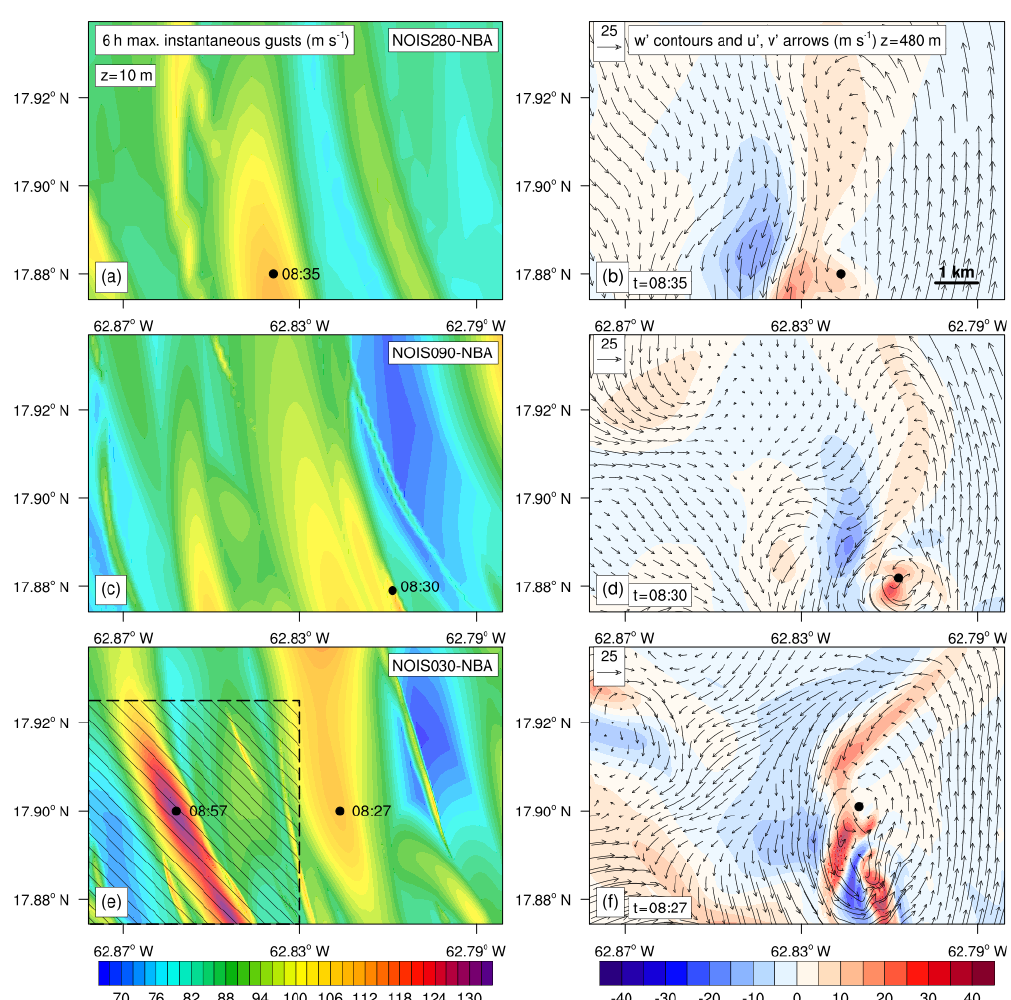
Figure 5. Comparison between the three resolutions: 280, 90, and 30m scale in the Saint Barthélemy 30m scale domain area (non-island experiments: NOIS280, NOIS090, and NOIS030). The results are not interpolated. (a, c, e) Maximum instantaneous gusts (m s − 1 ) occurring at 10m during the 6h of simulation (history output interval of 1min). (b, d, f) At the 480m level, perturbation vertical velocity (ms − 1 ) and perturbation horizontal wind vectors at 08:35 (b) , 08:30 (d) , and 08:27 (f)